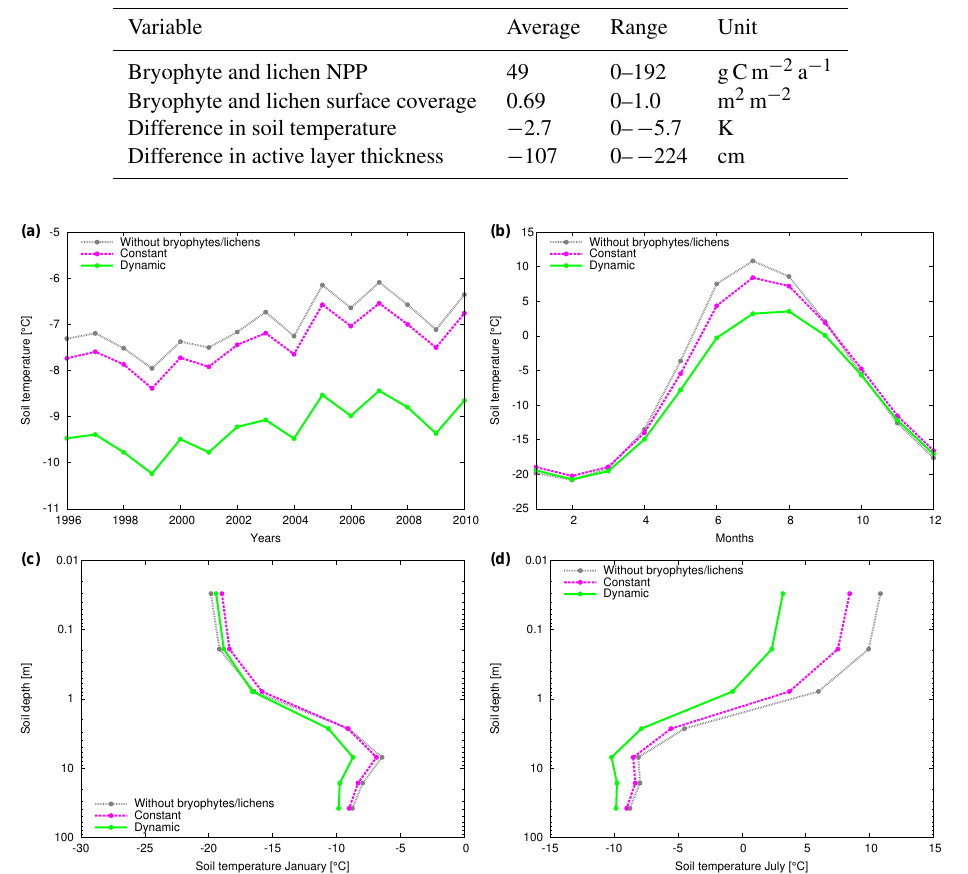
Figure 5. Temperature of the uppermost soil layer (a, b) and the whole simulated soil column (c, d) , averaged over the study region for the biomes boreal forest and tundra. The dots stand for (a) annual average values, (b) monthly average values, or (c, d) values at the mid-depth of a soil layer in JSBACH. The mid-depths of the layers are at 0.03, 0.19, 0.78, 2.68, 6.98, 16.4 and 38.11m depth. Without denotes a transient simulation from 1901 to 2010 without a bryophyte and lichen layer, Constant denotes an equivalent simulation, but including an organic layer with constant coverage and thermal properties and Dynamic stands for a bryophyte and lichen layer with dynamic coverage and thermal